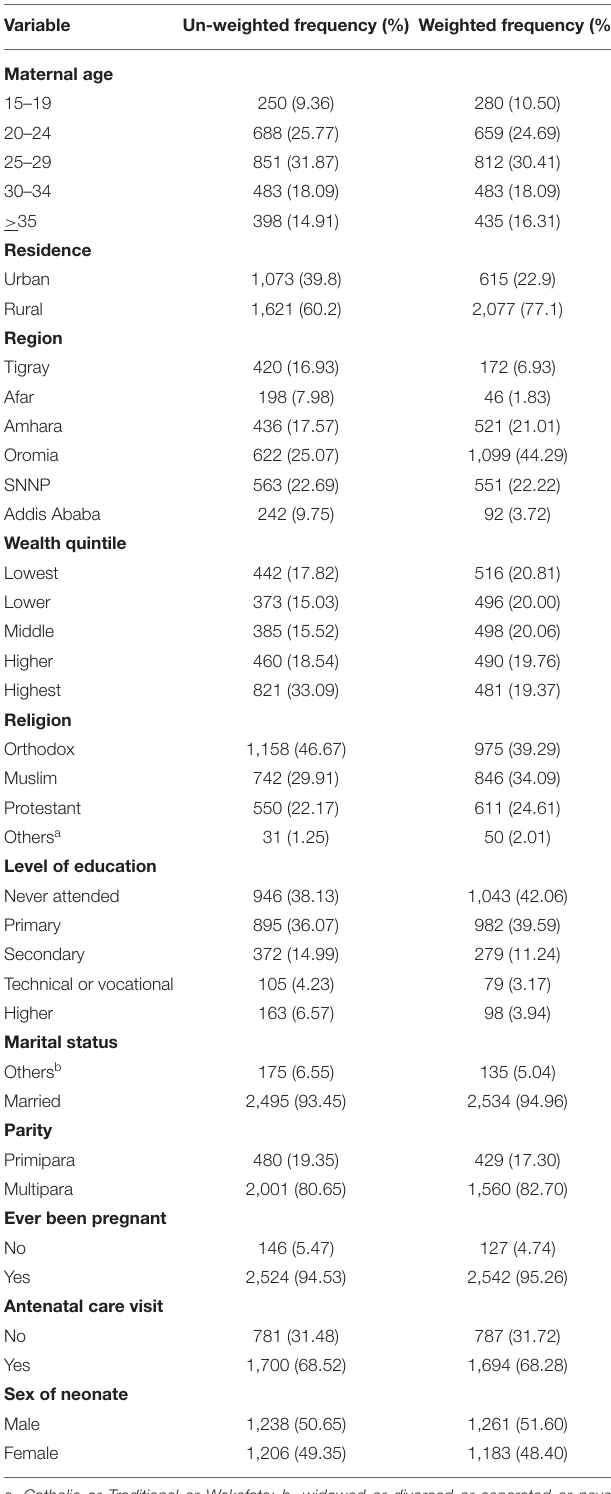
TABLE 1 | Frequency and percentage of study participants’ characteristics in Ethiopia 2020 ( n = 2,481).